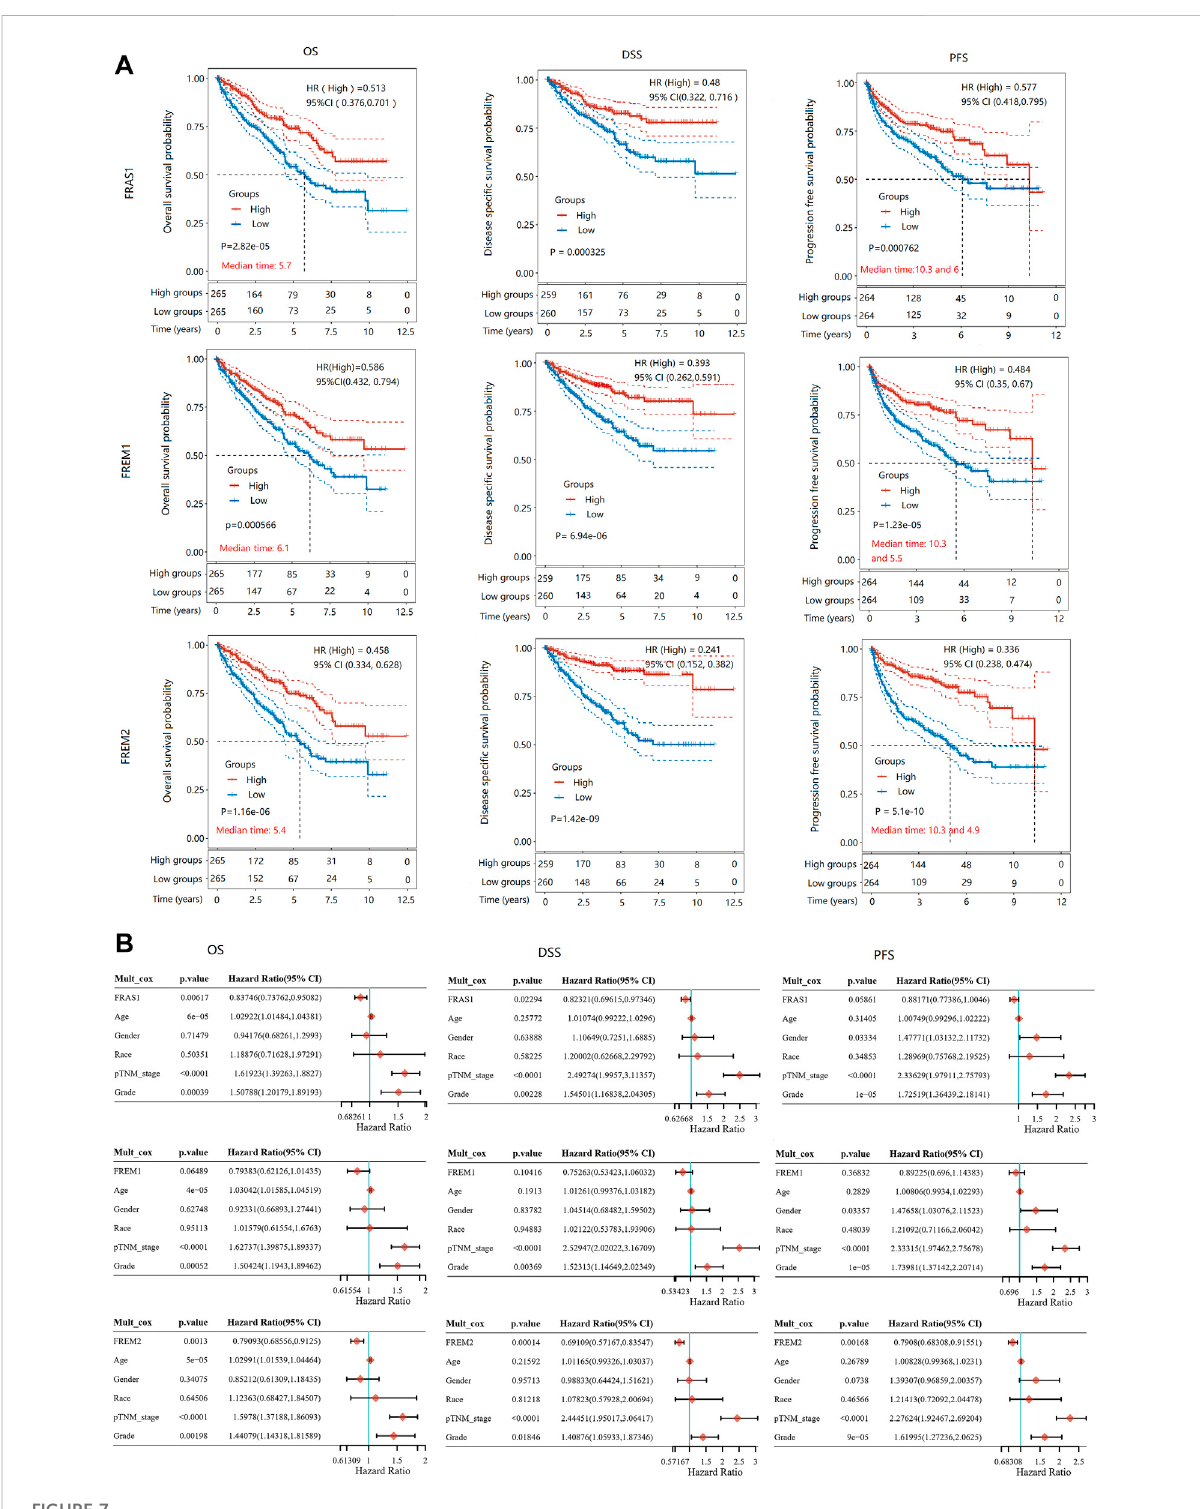
FIGURE 7 TheprognosticvalueofmRNAlevelofFRAS1/FREMfamilymembersinKIRCpatients. (A) Survivalcurvescomparingthehighandlowexpression of FRAS1, FREM1 and FREM2. (Kaplan-Meier survival analysis). (B) Hazard ratio and p value of constituents involved in multivariate Cox regression adjusted for clinical parameters (age, gender, race, TNM stage and